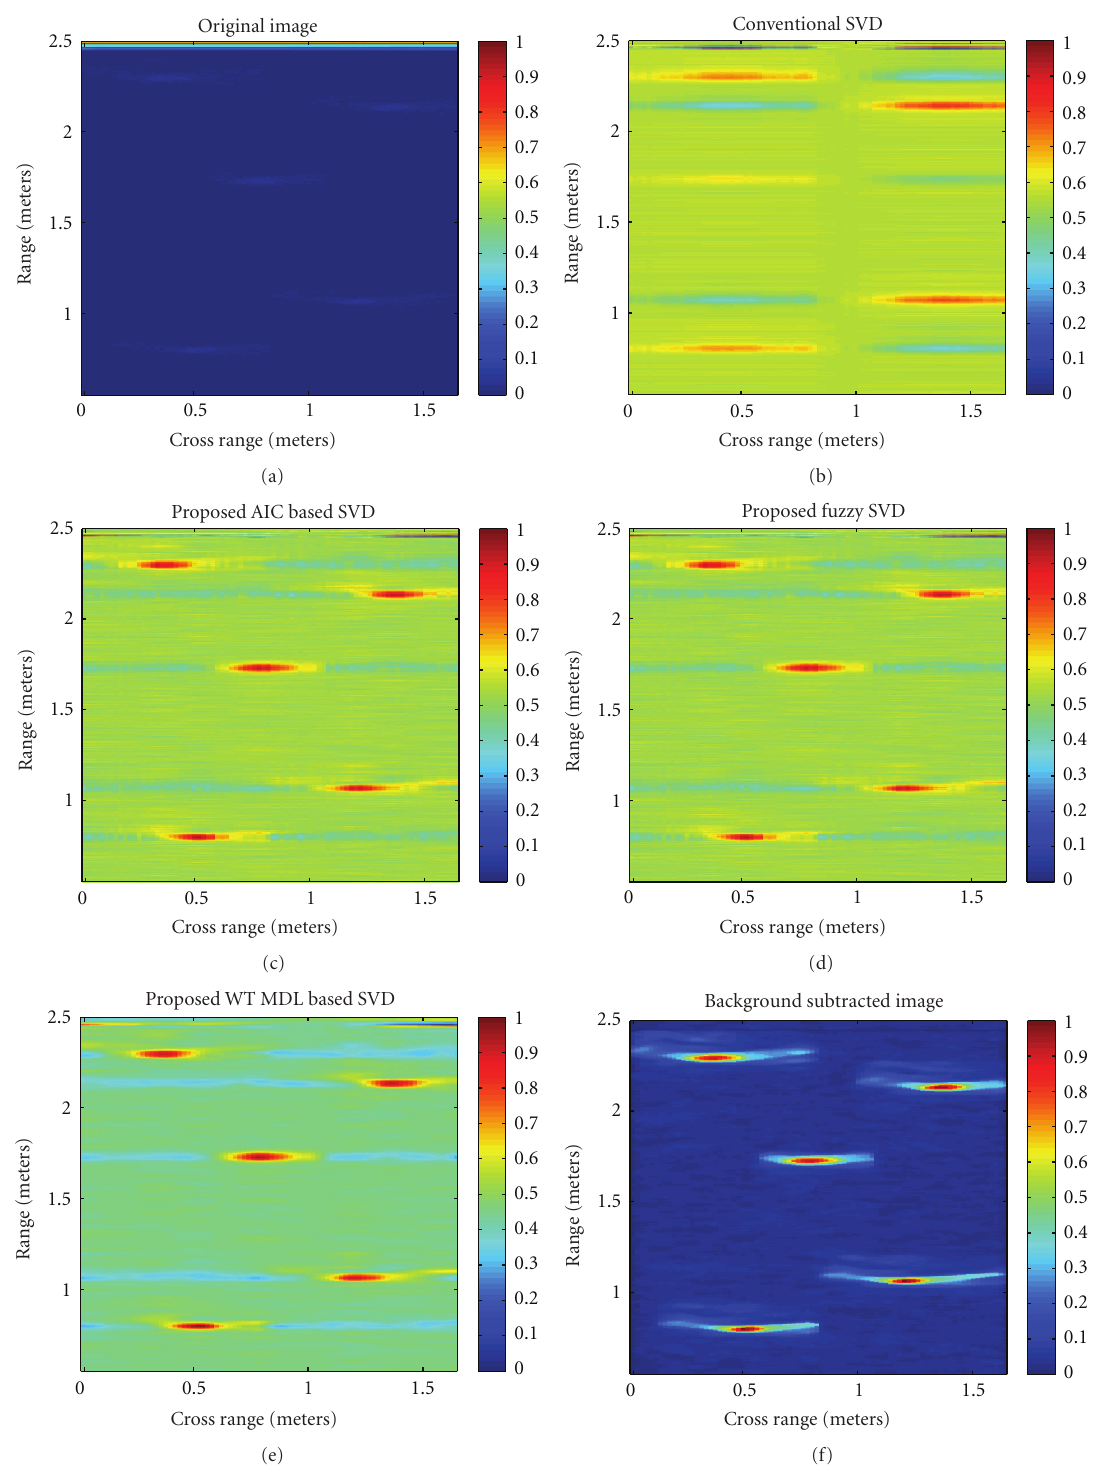
Figure 15: Example 3: Multiple (five) targets (a) original image, (b) conventional SVD, (c) AIC-based SVD, (d) MDL-based SVD, (e) WT MDL-based SVD, and (f) background subtracted